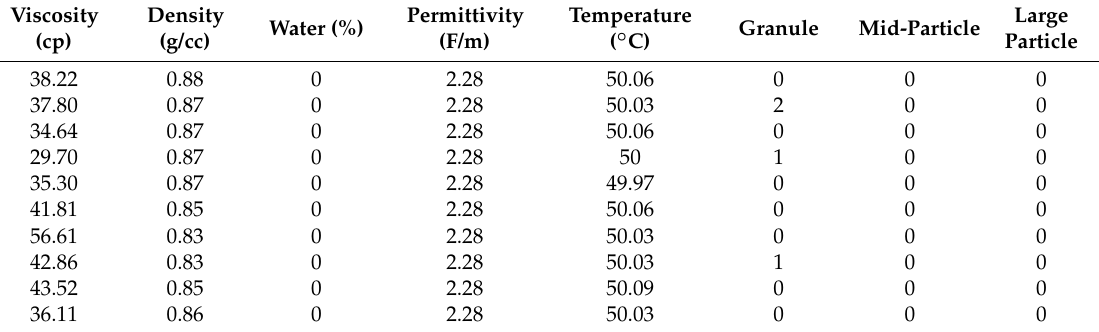
Table 5. Part of online oil monitoring data during severe wear of